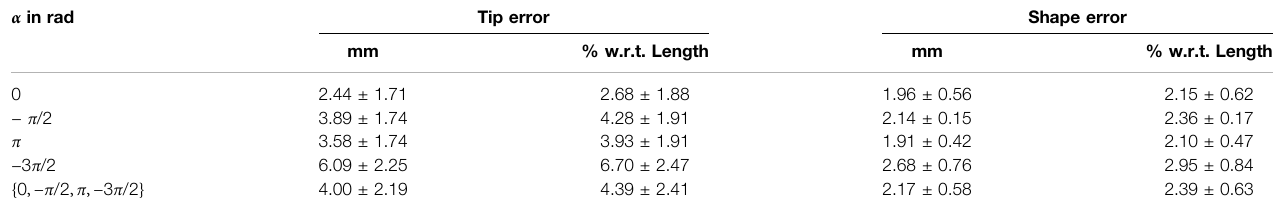
TABLE 2 | Average tip errors and backbone shape errors for different values of α . Mean and standard deviation of the errors are listed. We report the absolute errors in millimetre and relative errors in % w.r.t. segment length L = 93 mm. α in rad